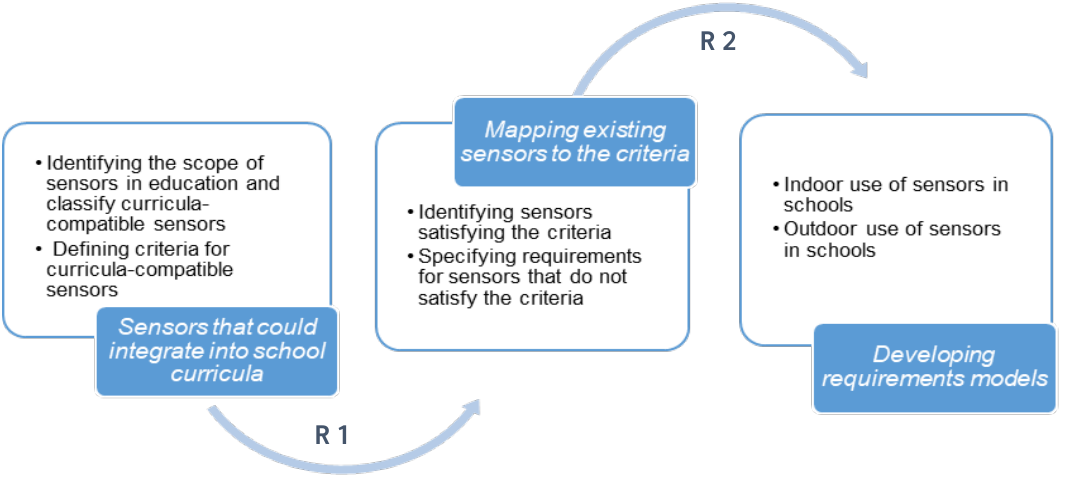
Figure 1. Research design to answer the research question “How can sensors facilitate the understanding of data and working with real world data, and how sensors can be designed for use in education?